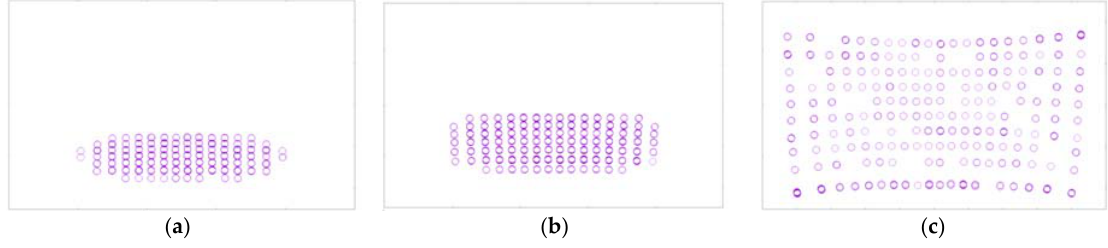
at the (cid:2870)